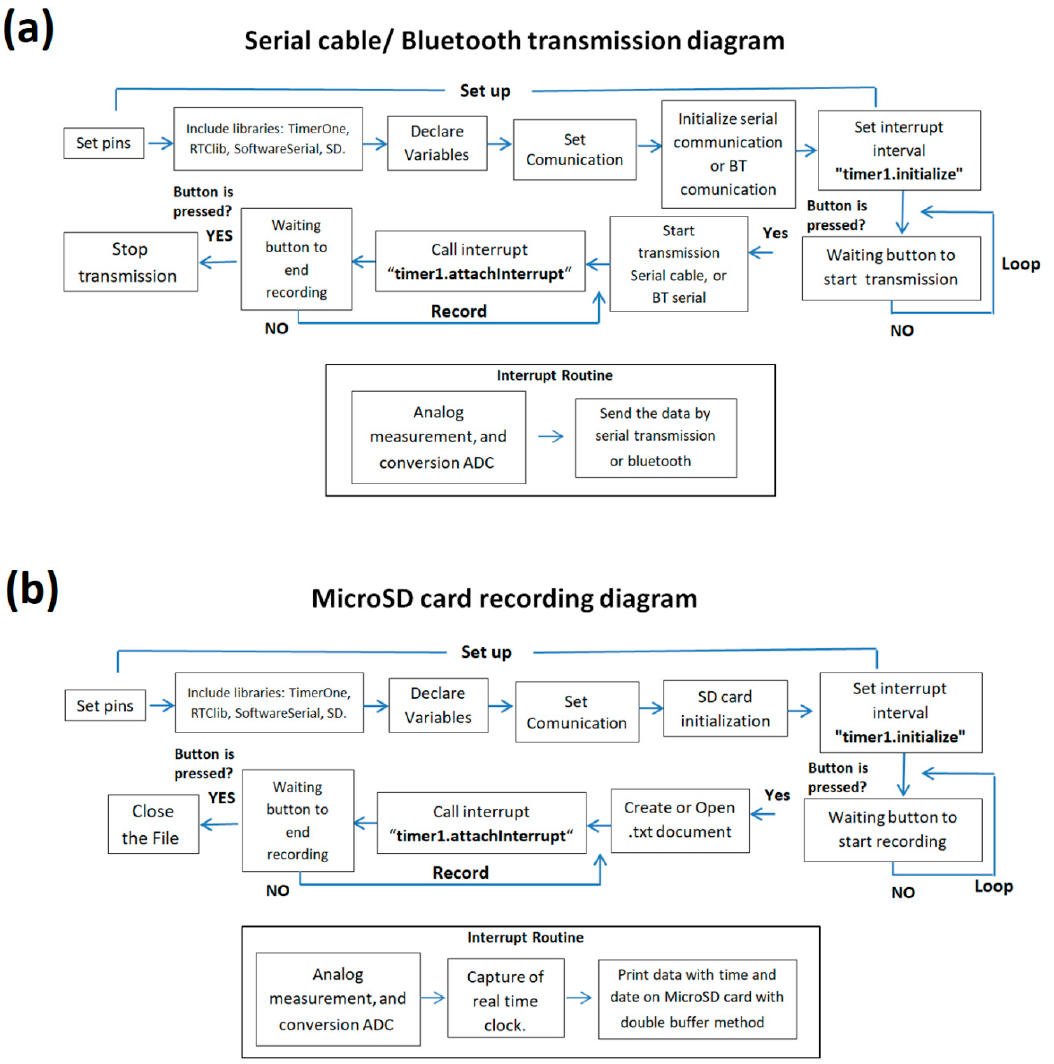
Figure 7. ( a ) Serial cable / Bluetooth transmission program diagram; ( b ) MicroSD card recording program diagram.